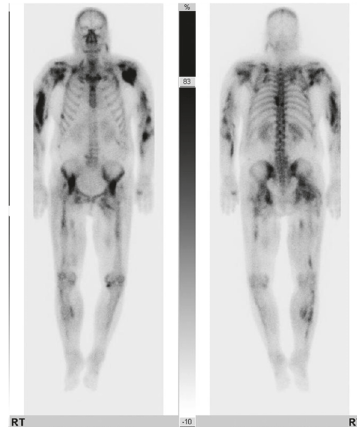
Figure 2: Whole body bone scintigraphy shows radioiodine uptake in multiple locations. Whole body bone scintigraphy shows radioio- dine uptake in the head, shoulder, hip, and both upper and lower extremities, suggesting rhabdomyolysis.